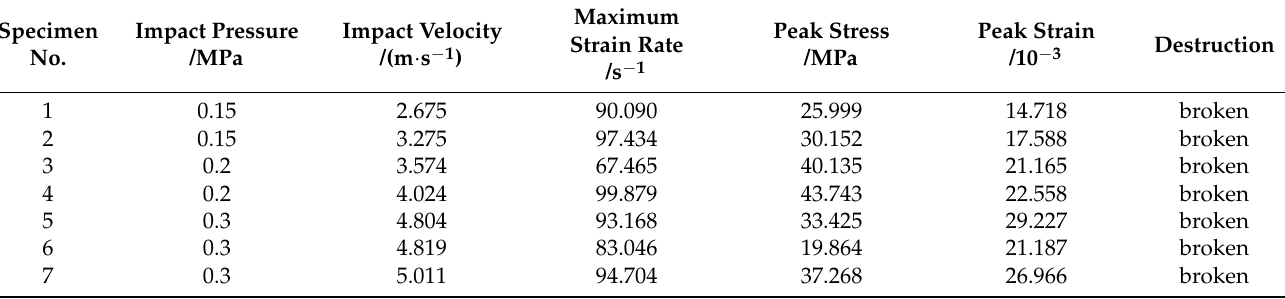
Table 2. Impact test results of hard coal